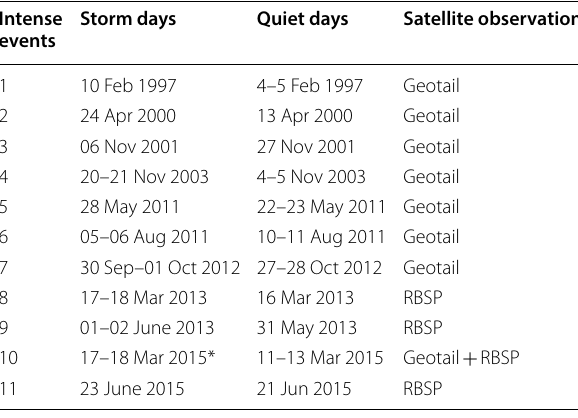
Asterisk (*) mark shows the special event having its main phase duration of nearly 15 h